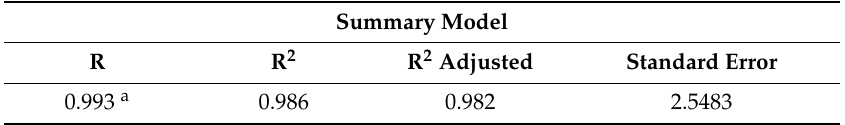
Table 11. Determination coefficients for topographic settlement and second modulus of PLT ( ɸ 600mm) at crown.